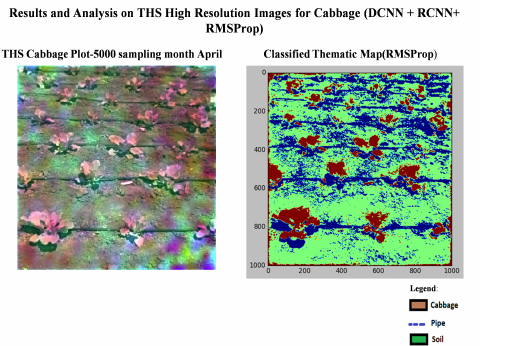
Figure 12: Results and analysis on THS high resolution imagery for cabbage using DCNN + RCNN + RMSProp optimiser